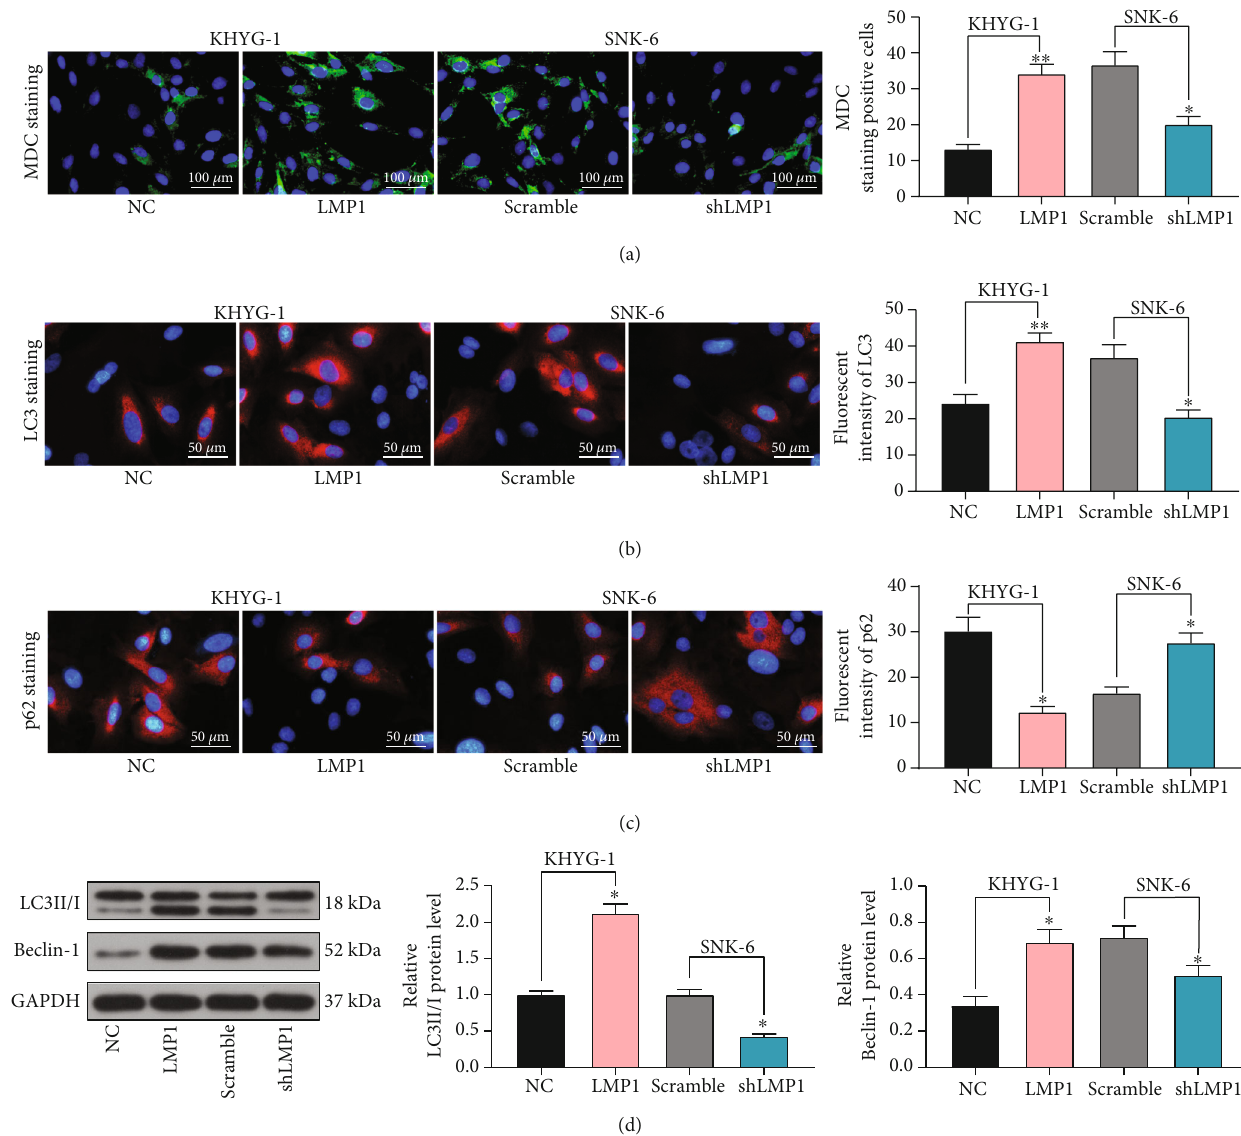
Figure 2: LMP1 overexpression accelerates the lymphoma cell autophagy after DDP treatment. (a) The lymphoma cell autophagy in the SNK-6 and KHYG-1 cells observed by MDC staining. (b and c) The expression level of LC3 and p62 was detected by immuno fl uorescence. (d) The expression levels of Beclin-1 and LC3 II/I were detected by western blot analysis. All data are displayed in the form of mean ± standard deviation . (a, b, d, and e) One-way ANOVA and Tukey ’ s multiple comparison test are used to test the signi fi cant di ff erence of data. ∗ p < 0 : 05 , ∗∗ p < 0 : 01